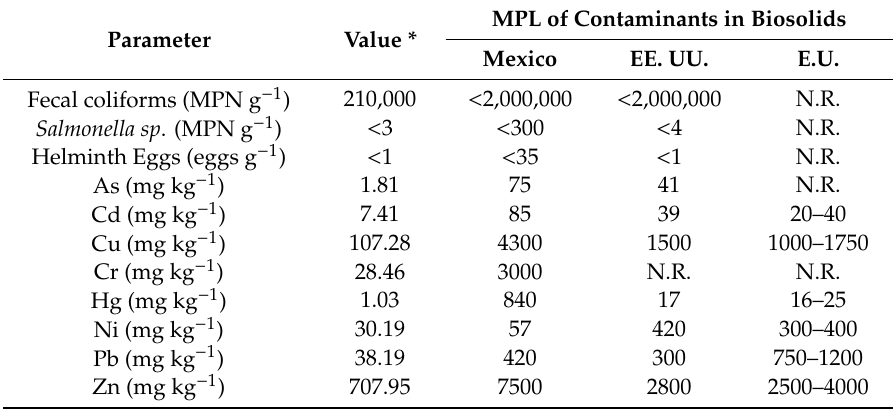
Table 1. Regulatory standards for the application of biosolids in soils established in national and international standards. MPL of Contaminants in Parameter Value *